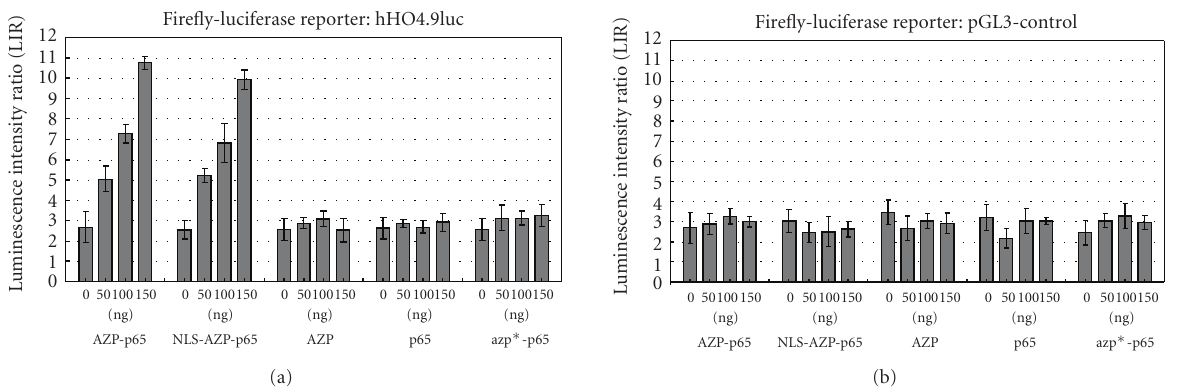
Figure 5: A ffi nity of the ATF to HMOX1 enhancer. Dual-luciferase reporter assay was performed; the candidate vectors were pcDNA3.1- AZP-p65-flag (AZP-p65), pcDNA3.1-NLS-AZP-p65-flag (NLS-AZP-p65), PUC57-AZP (AZP), pcDNA3.1-NLS-eGFP-p65-flag (p65), and pcDNA3.1- azp ∗ -p65-flag (azp ∗ -p65). For each of the vectors, four dose gradients (0, 50ng, 100ng, and 150 ng) were used. The firefly- luciferase reporters were (a) hHO4.9luc and (b) pGL3-control, respectively. The data represent the means ± S.D.